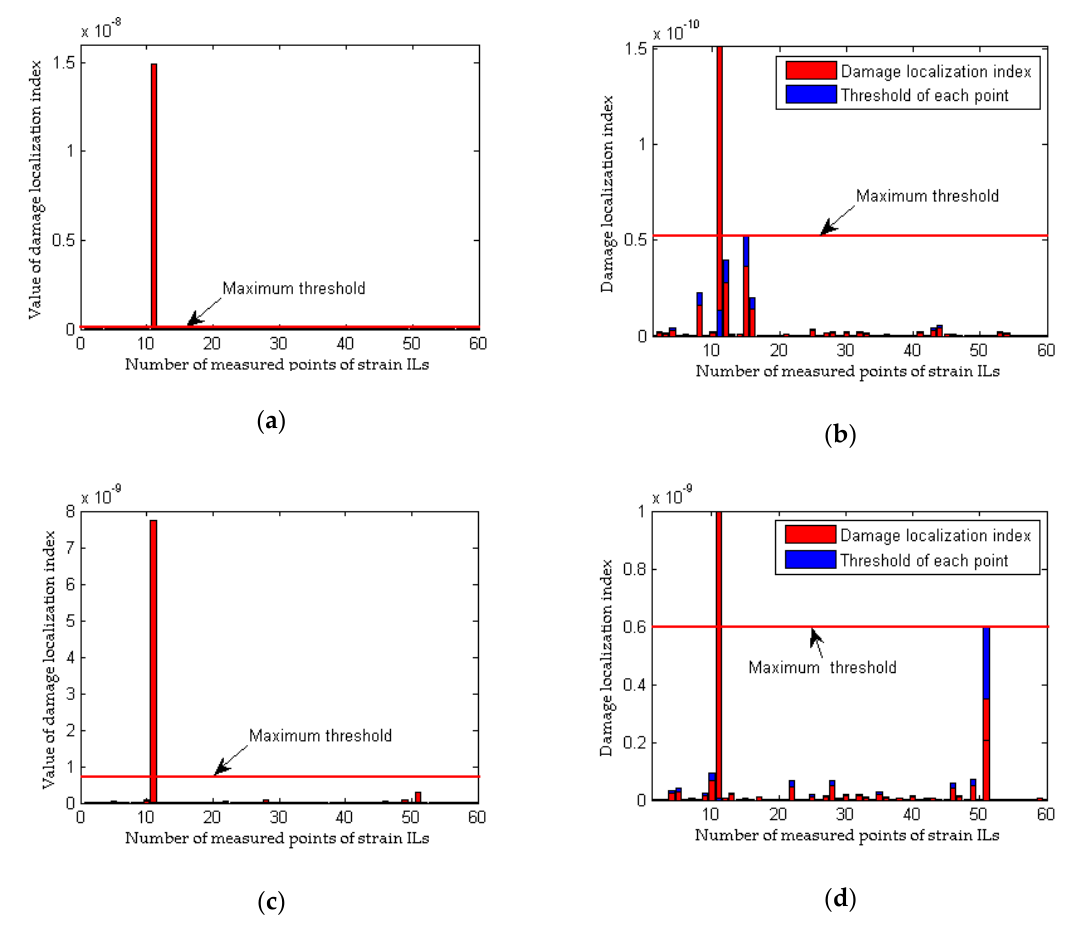
Figure 9. Results of the proposed method considering the effects of measurement noise (for a single damaged elements): ( a ) results of the proposed method for case 3; ( b ) detailed magnification of the results of the proposed method for case 3; ( c ) results of the proposed method for case 4; ( d ) detailed magnification of the results of the proposed method for case 4.